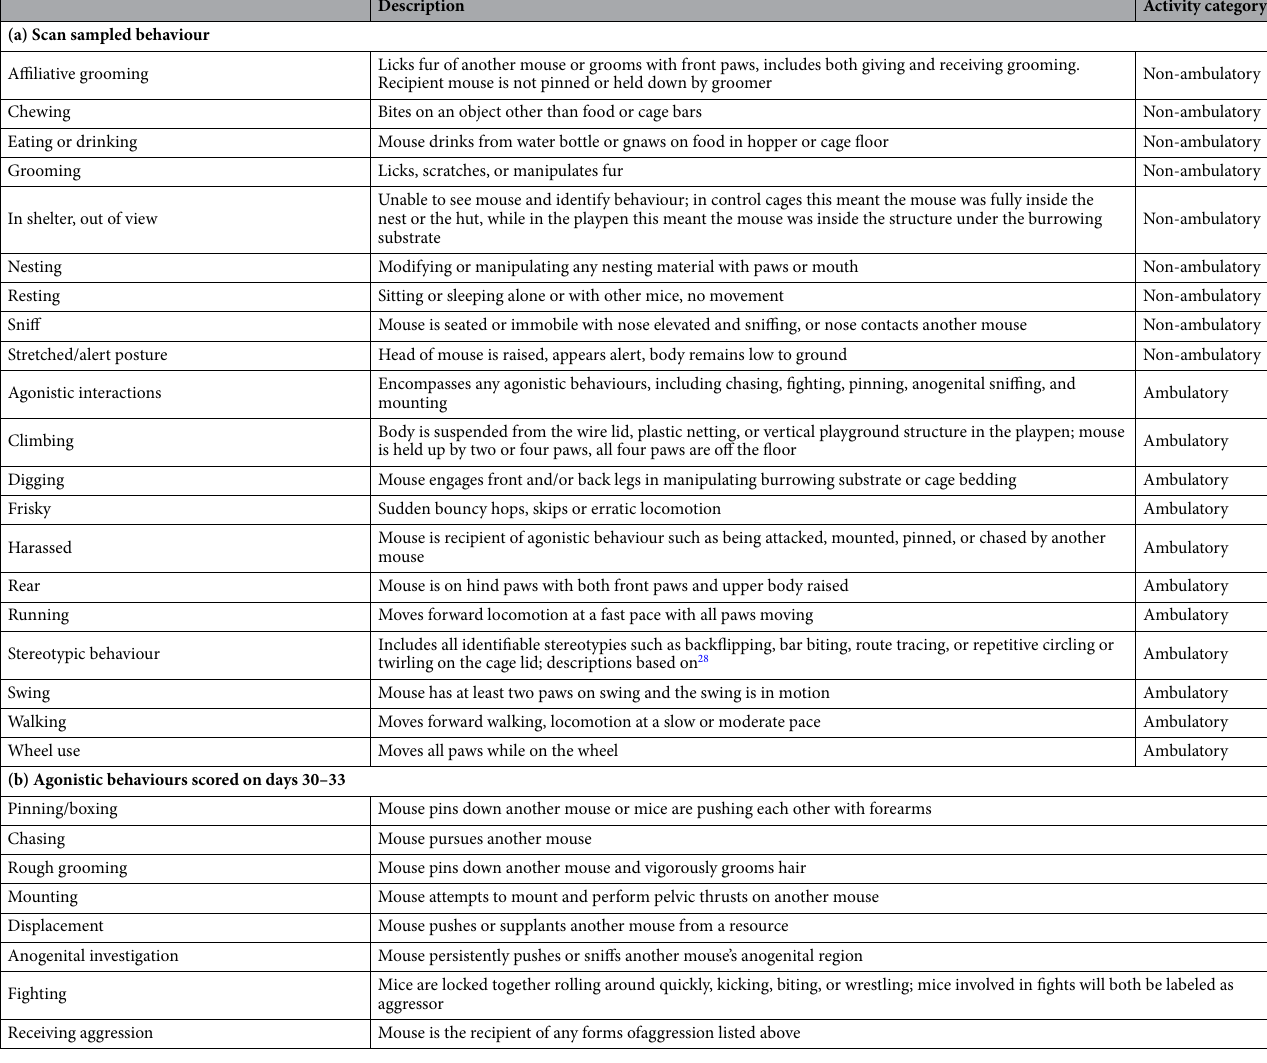
Table 2. Ethogram used for scan sampling and focal sampling observations. (a) The ethogram for scan sampling observations is listed first and was adapted from Makowska et al. 26 and Draper 27 . (b) For focal sampling of agonistic interactions of the playpen mice on days 30–33, only agonistic behaviours listed in the lower half of the table were scored (adapted from Nip et al. 11